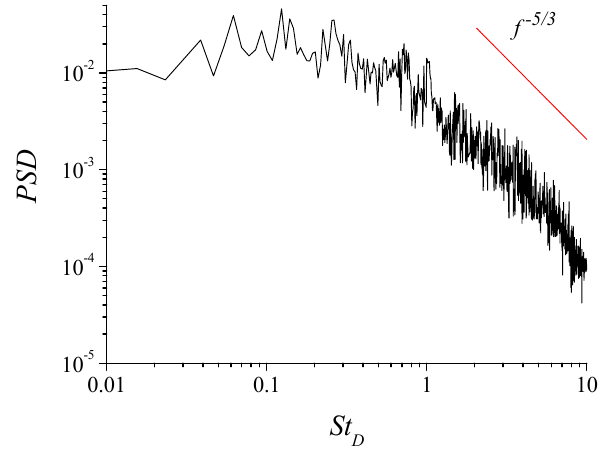
Figure 5. Coherent structures of the unforced jet, visualized by the iso-surface of pressure and colored by the streamwise velocity magnitude, p / ρ U j 2 = − 0.03.